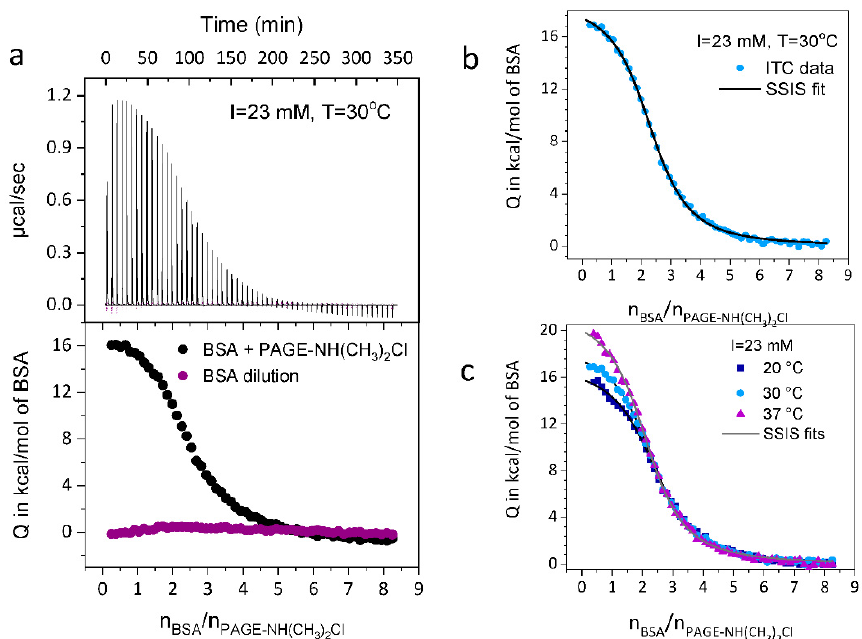
Figure 2. ITC-analysis exemplified for polymer 4 . ( a ) Top panel: the raw data from the titration of BSA to PAGE-NH(CH 3 ) 2 Cl (black spikes) along with the raw dilution curve of BSA by buffer (purple spikes) at T = 30 °C and I = 23 mM. Lower panel: the integrated heats of each injection. ( b ) The respective SSIS-fits of curves obtained at T = 30 °C and ( c ) T = 20, 30 and 37 °C. The thermodynamic data derived from these fits are gathered in Table S6.